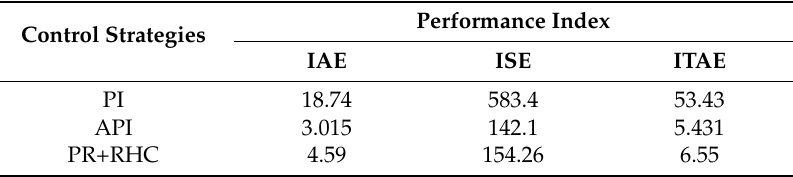
Table 6. Performance evaluation of the designed control strategies for I d